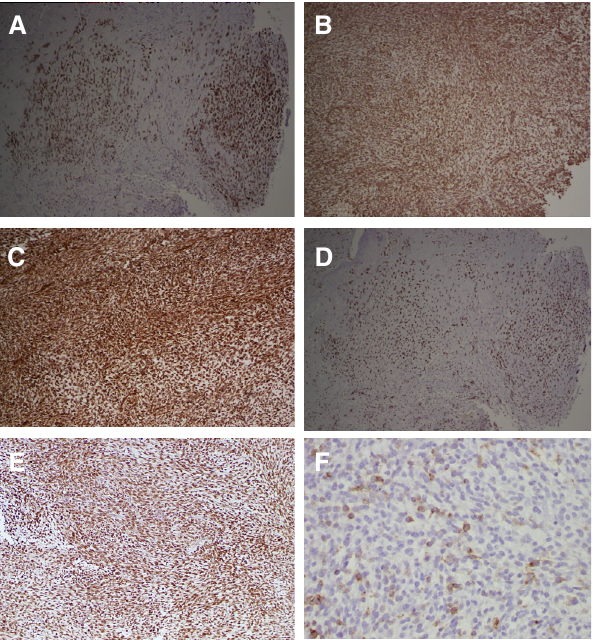
Figure 4. Immunohistochemistry. Tumor cells were strongly positive for: BCL-2 (× 100 magnification) ( 4a ), CD 99 (× 100 magnification) ( 4b ), Vimentin (× 100 magnification) ( 4c ), FLI1 (× 100 magnification) ( 4d ) and NSE (× 100 magnification) ( 4e ). They also showed focal scattered positivity for EMA (× 400 magnification) ( 4f